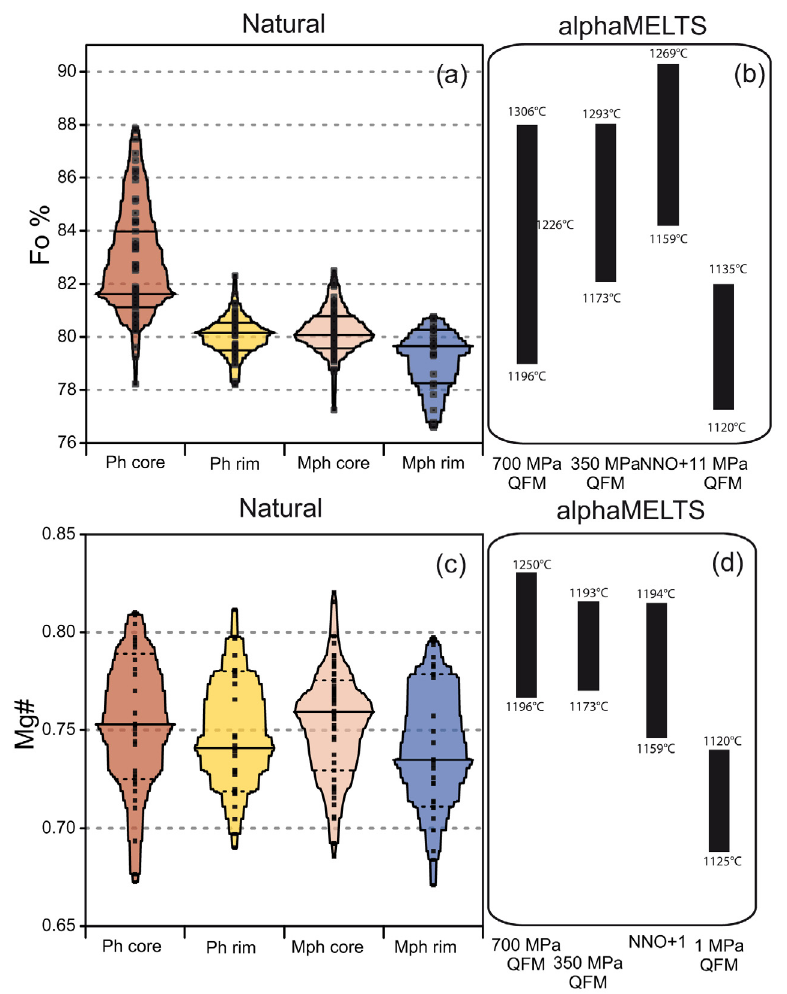
on molar basis) respectively in natural olivine and clinopy- Figure 8. (a-c) Box percentile plots of Forsterite % and Mg# (MgO/MgO+FeO tot roxenes erupted during 2011-12 El Hierro eruption grouped on the basis of size of the minerals (Phenocrysts ≥ 500 µm = Ph; Microphenocrysts ≤ 500 µm = Mph) and position (core-mantle and rim). Width of the box is proportional to the distribution height. Median (solid), 25th, and 75th percentiles (dotted) are marked with line segments across the box; (b-d) Range of Forsterite % and Mg# composition obtained from thermodynamical modeling of fractional crystallization at different pressure and oxidizing conditions in the reported temperature